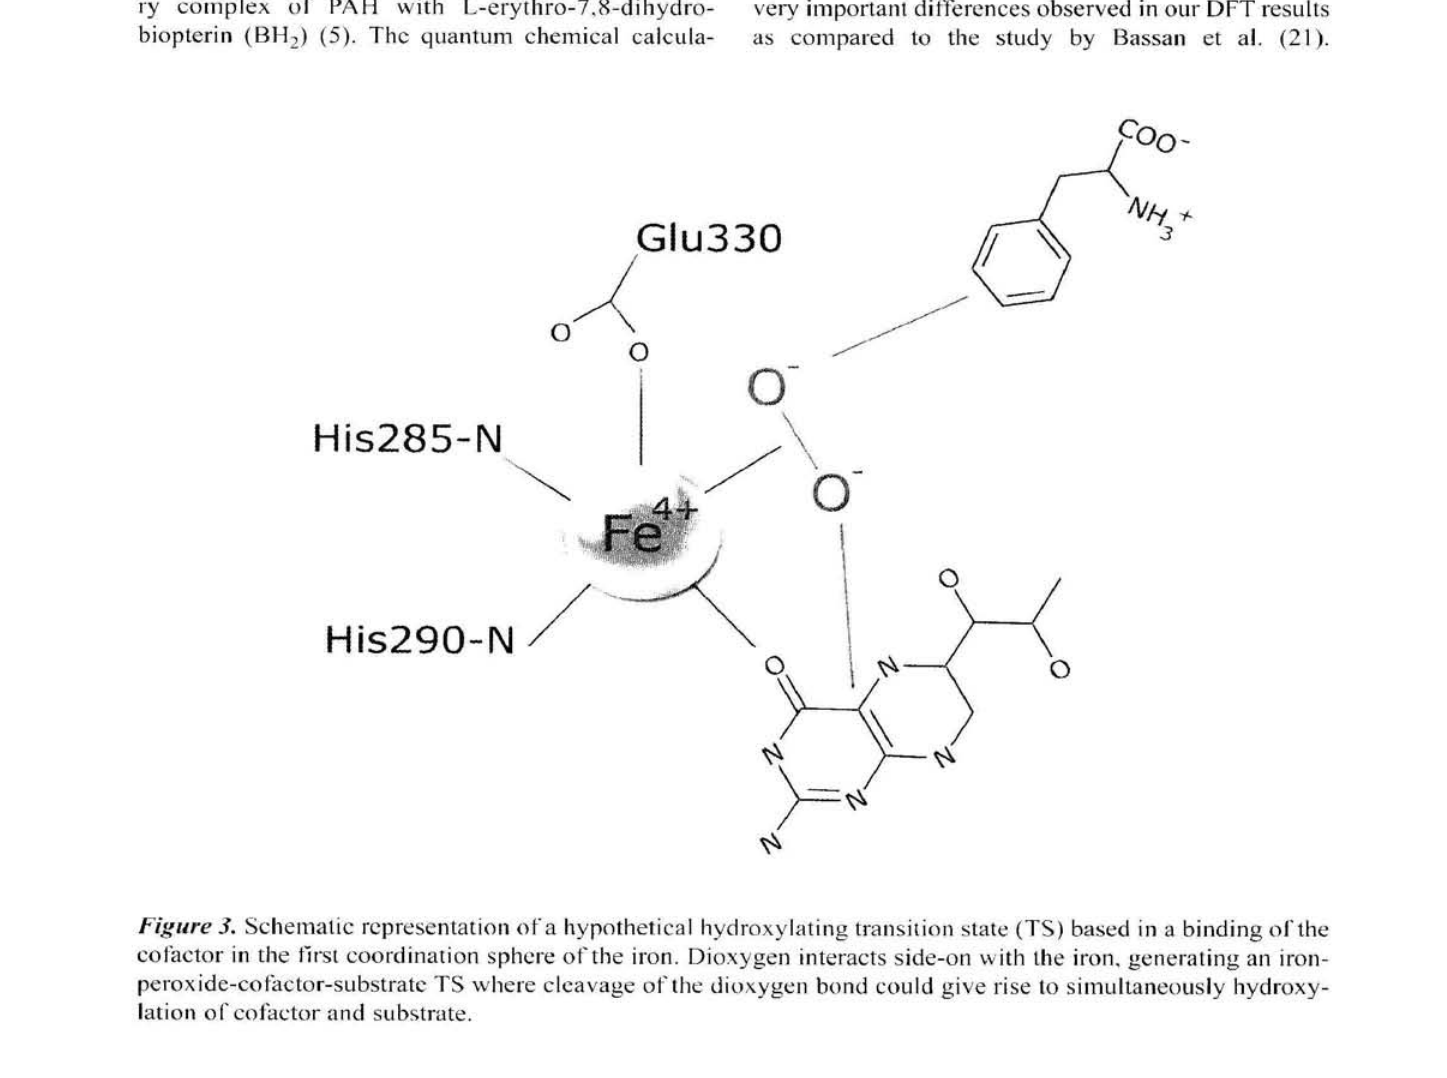
Figure 3. Schematic representation of a hypothetical hydroxylating transition state (TS) based in a binding of the cofactor in the first coordination sphere of the iron. Dioxygen interacts side-on w ith the iron, generating an iron- peroxide-cofactor-substrate TS where cleavage of the dioxygen bond could give rise to simultaneously hydroxy- lation of cofactor and